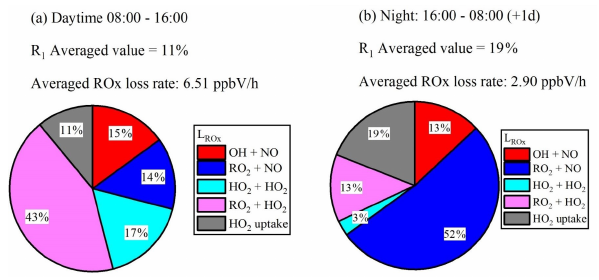
Figure 3. R 1 calculated by the NEq. Pie charts show the values of R 1 and the loss rates for RO x during daytime (a) and night- time (b) . The averaged daytime (08:00–16:00) RO x radical loss rate is 6.5ppbVh − 1 , and that for night-time (16:00–08:00 ( + 1d)) is 2.9ppbVh − 1